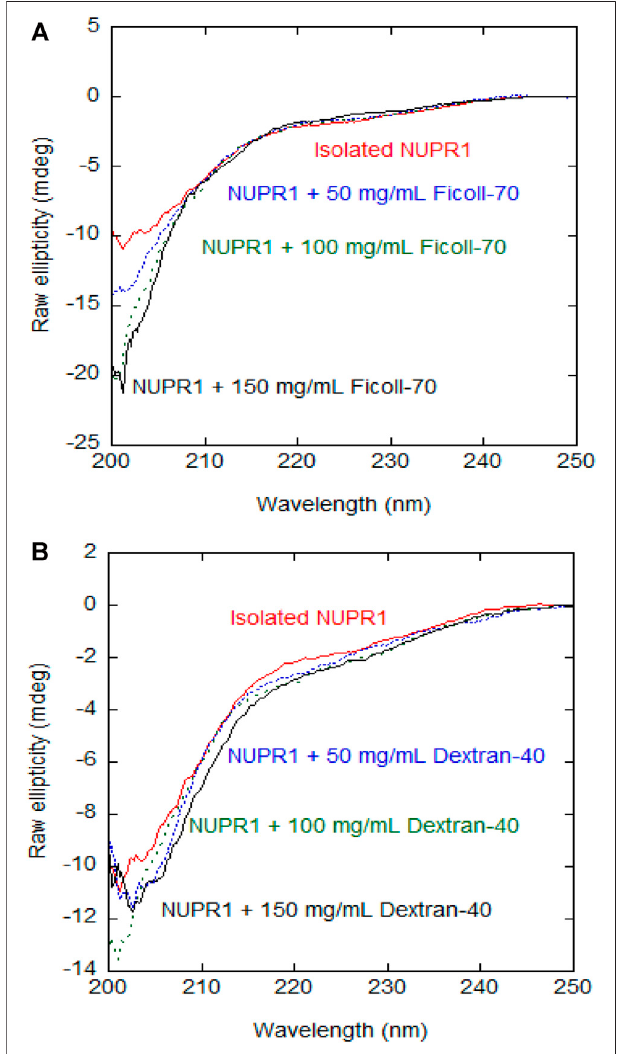
FIGURE 1 | Far-UV CD spectra of wild-type NUPR1 in the presence of crowders : Far-UV CD spectra of wild-type NUPR1 at different concentrations of Ficoll-70 (A) and Dextran-40 (B) . Experiments were carried out in buffer Tris (50 mM, pH 7.2) at 25 °